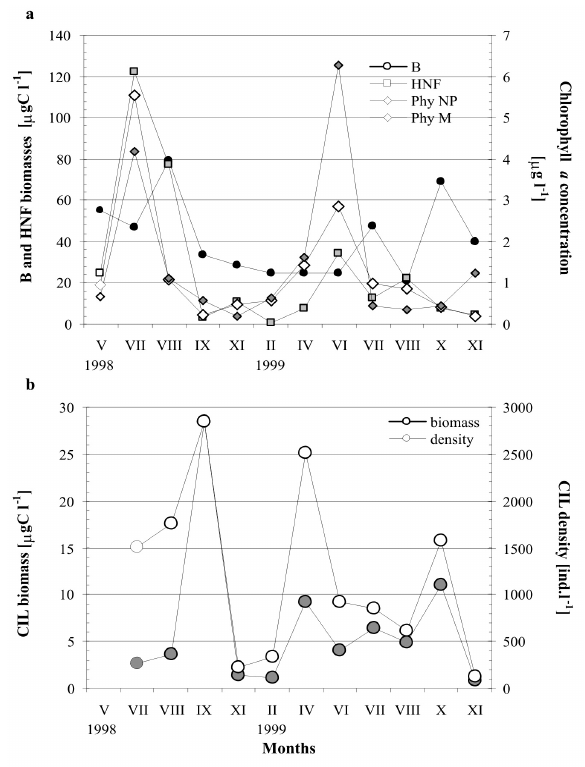
F IG . 8. – Seasonal variability in average values of biomasses of bac- terioplankton, HNF, ciliates and chlorophyll a concentration (B, bacterioplankton; HNF, heterotrophic nanoflagellates; Phy NP, nano- and pico-phytoplankton fraction; Phy M, microphyto- plankton; CIL, ciliated